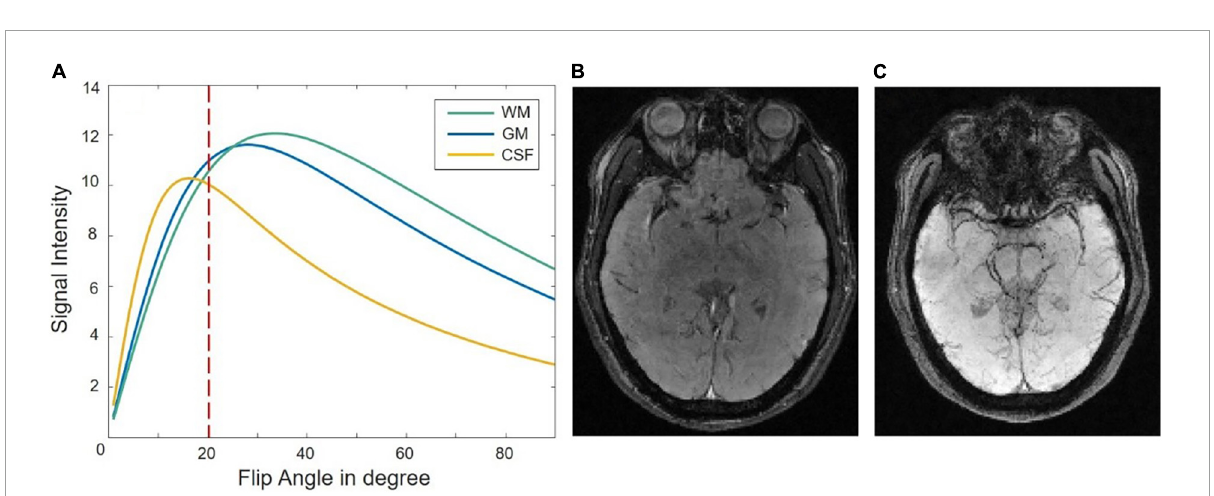
in Figure 2 . The intensity contrast of the different tissues of the raw image in Figure 2B fits the simulation curve of Figure 2A . The GM/WM contrast is almost nonexistent and CSF is suppressed and darker than the GM/WM. The magnitude image as shown in Figure 2B has a reasonable SNR of 47.1067 as calculated which the mean of the signal